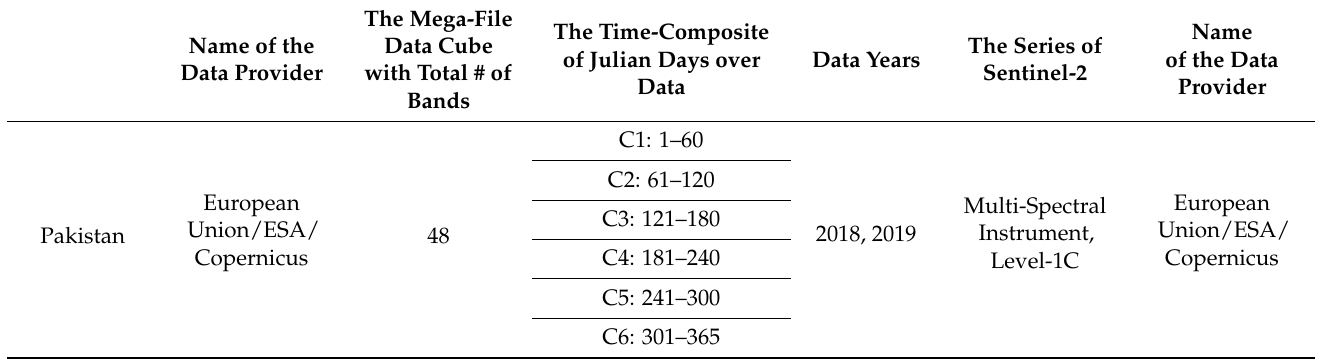
Table 2. Sentinel 2: MSI 10 m to 60 m data used in the study characteristics multi-temporal